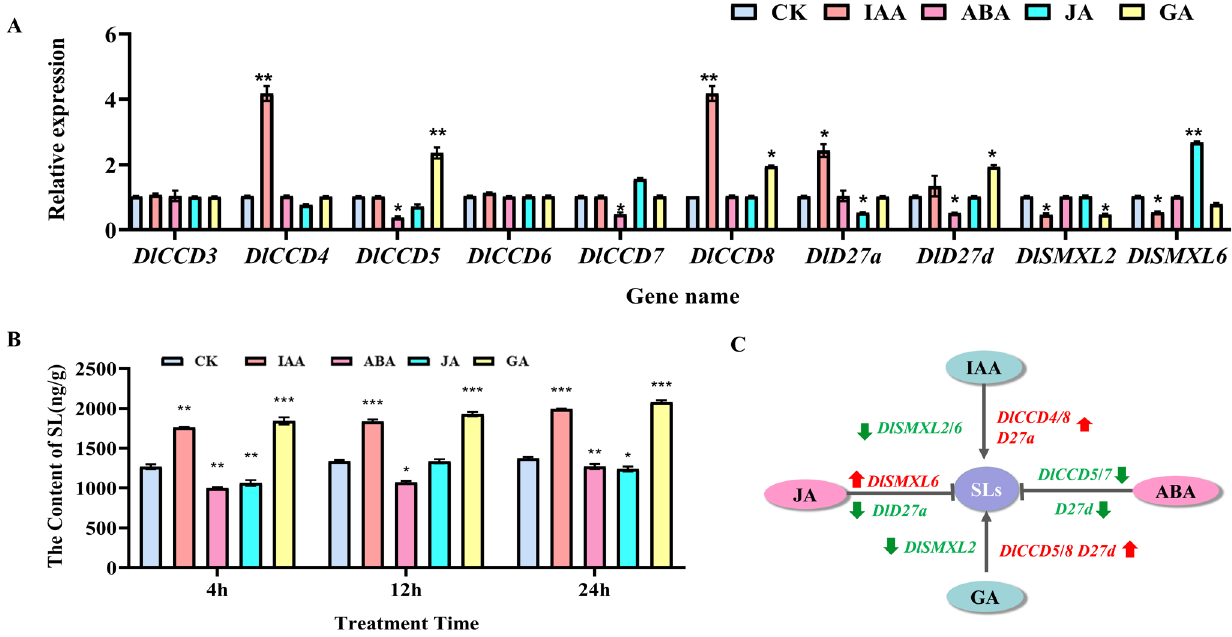
Figure 6. ( A ) The gene expression analysis and SL content changes of longan ECs treated with different hormones for 24 h. ( B ) Changes in the endogenous SL content of longan ECs under hormones treatment. ( C ) Schematic diagram of changes in the content of SLs and expression analysis of SL pathway genes respond to four hormone treatments for 24 h by qRT-PCR in longan ECs. Red and green mark indicate upregulated and downregulated genes. The arrow indicates promoting the process. The “T” line indicates inhibiting the process. Significant differences are indicated with “*” ( p < 0.05), “**” ( p < 0.01), “***” ( p < 0.005).